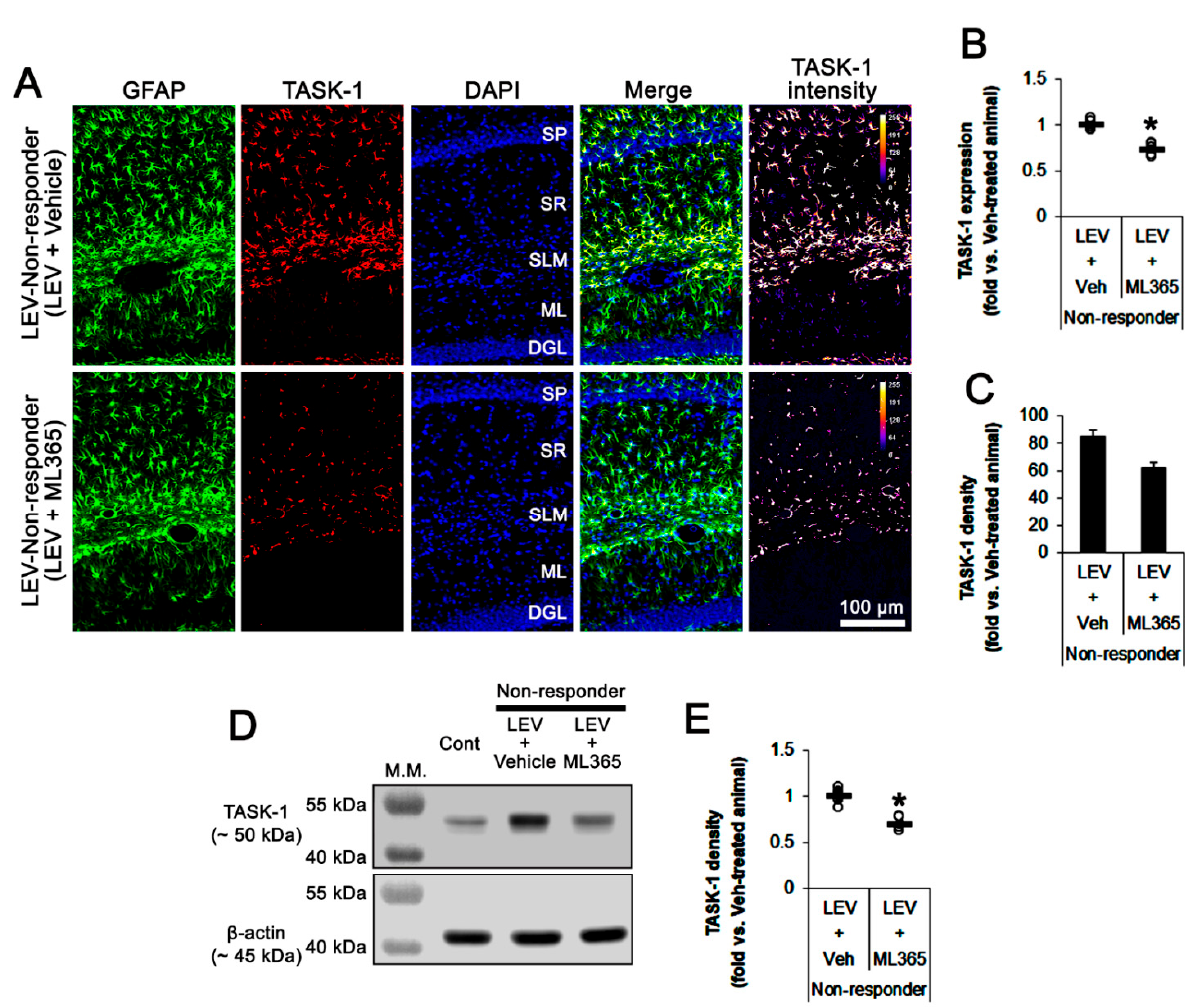
Figure 7. The effect of ML365 co-treatment with levetiracetam (LEV) on TASK-1 expression in non-responders to LEV. ML365 co-treatment reduced TASK-1 expression in CA1 astrocytes within the hippocampus of non-responders. ( A ) Representative photos of TASK-1 expression in the hippocampus (SP, stratum pyramidale; SR, stratum radiatum; SLM, stratum lacunosum-moleculare; ML, molecular layer of the dentate gyrus; DGL, dentate granule cell layer). ( B ) Quantitative analyses of the effect of ML365 co-treatment on TASK-1 expression based on immunohistochemical data. Open circles indicate each individual value. Horizontal bars indicate the mean value. Error bars indicate SEM (*, p < 0.05 vs. LEV-treated animals; Student’s t -test). ( C ) Quantitative analyses of the effect of ML365 co-treatment on the fraction of TASK-1 positive astrocytes in total astrocytes (*, p < 0.05 vs. control animals; Student’s t -test; error bars, SEM). ( D ) Representative images for Western blots of TASK-1 protein expression in the hippocampal tissues. ( E ) Quantifications of TASK-1 levels based on Western blot results ( * , p < 0.05 vs. LEV-treated animals; Student’s t -test).